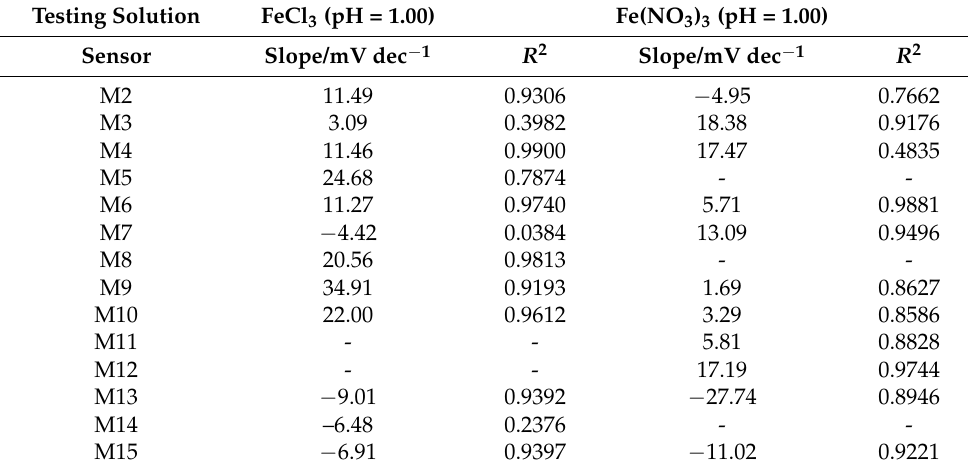
Table 3. Results of testing M2–M15 membranes in EB1 towards ferric cations.